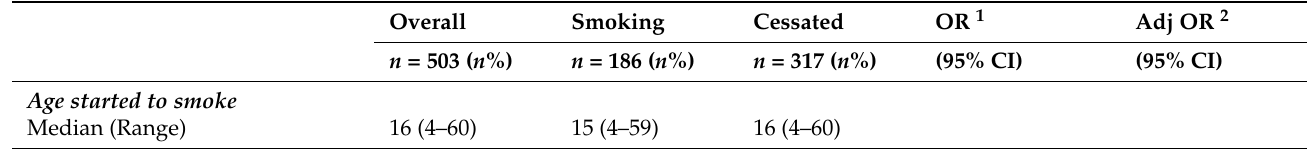
Table 2. Smoking characteristics of head and neck cancer patients ( n = 503) who are current smokers ( n = 186) or had cessated ( n =